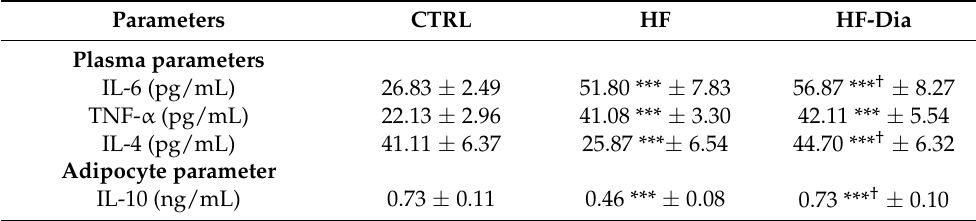
Table 2. Effects of D. lutheri on inflammatory